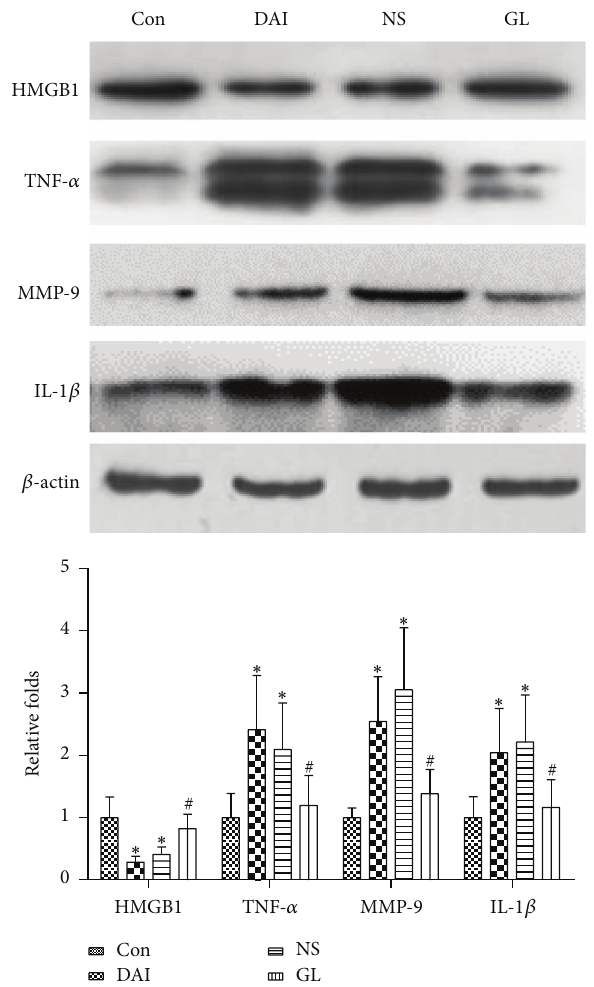
Figure 5: Expression of HMGB1, TNF- 𝛼 , MMP-9, and IL-1 𝛽 induced by GL pretreatment, at 24h after DAI. In the DAI and DAI + NS groups, the HMGB1 level clearly decreased compared with the control group. Pretreatment with GL significantly inhibited the decrease of HMGB1 after DAI. Furthermore, pretreatment with GL significantly decreased the expression of TNF- 𝛼 , MMP-9, and IL-1 𝛽 compared with DAI + NS group. ∗ 𝑝 < 0.05 compared with control group; # 𝑝 < 0.05 compared with DAI